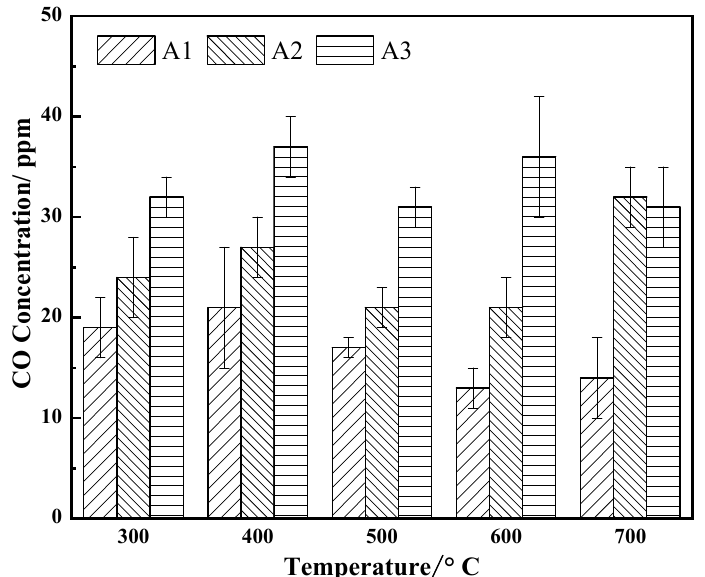
Figure 8. The concentration of CO during thermal desorption of simulated polluted soils under 20% O 2 /N 2 atmosphere at different temperatures. (A1, sample of 1 mL waste oil mixed with 25 g soil; A2, sample of 2 mL waste oil mixed with 25 g soil; A3, sample of 3 mL waste oil mixed with 25 g soil).